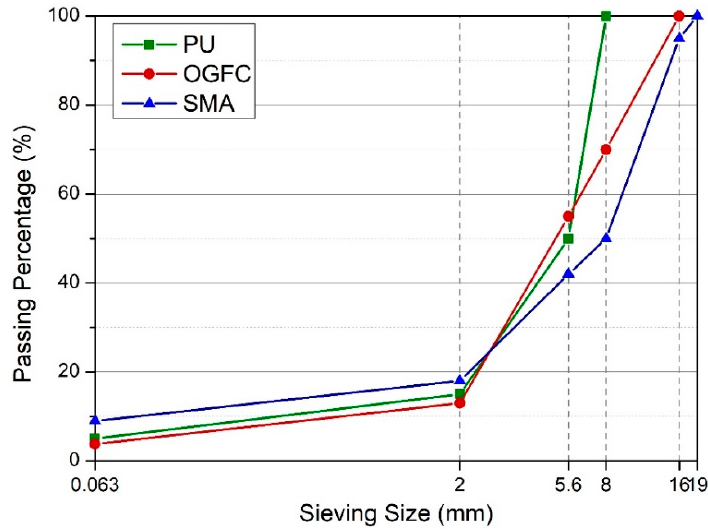
Figure 2. Grain size distribution of PU, open graded friction course (OGFC), and stone mastic asphalt (SMA). Table 1. Mix design of PU mixture.